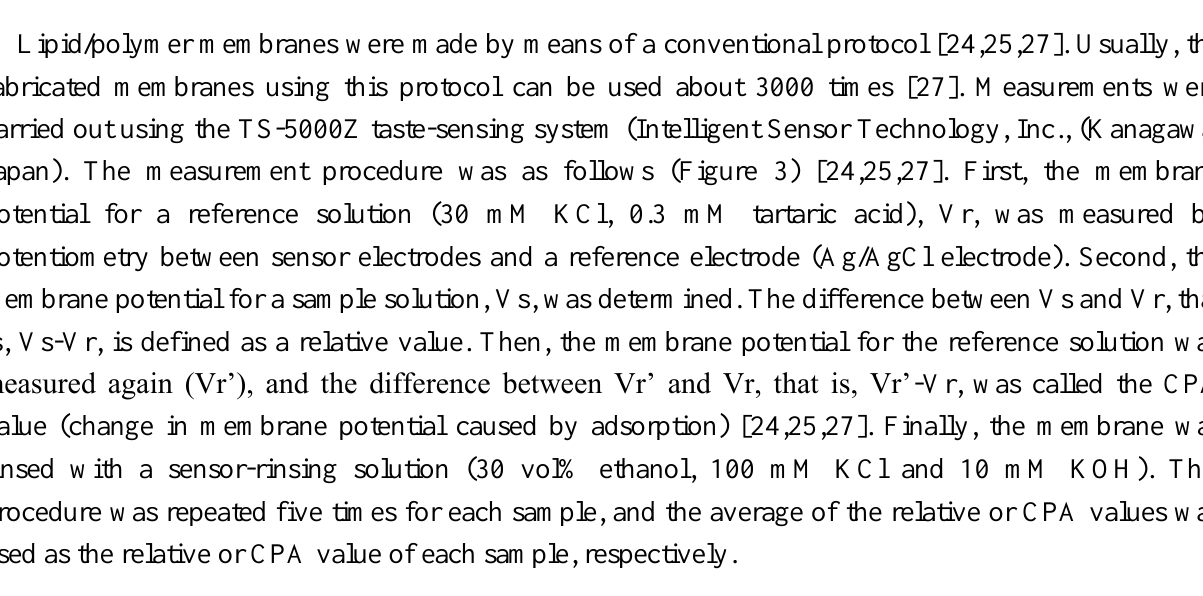
Figure 3. Measurement procedure of taste